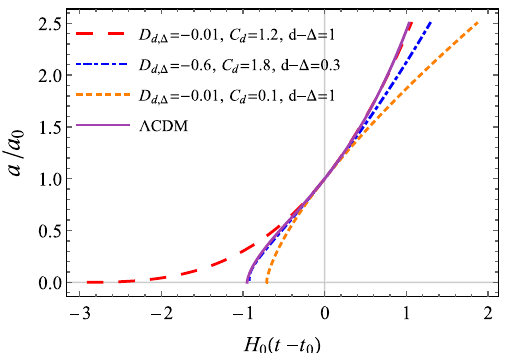
Fig. 1 Time evolution of normalized scale factor a / a 0 for several combinations of the parameters. The horizontal axis is normalized as H 0 ( t − t 0 ) . t 0 and a 0 are the current values of time and scale fac- tor, respectively. The possible behaviors of the solution are: i-convex curve (red dashed), ii-concave curve (orange dotted), and iii-curve with change of concavity (blue dot-dashed). The fine-tuned standard Λ CDM model (purple solid curve) is showed for comparison